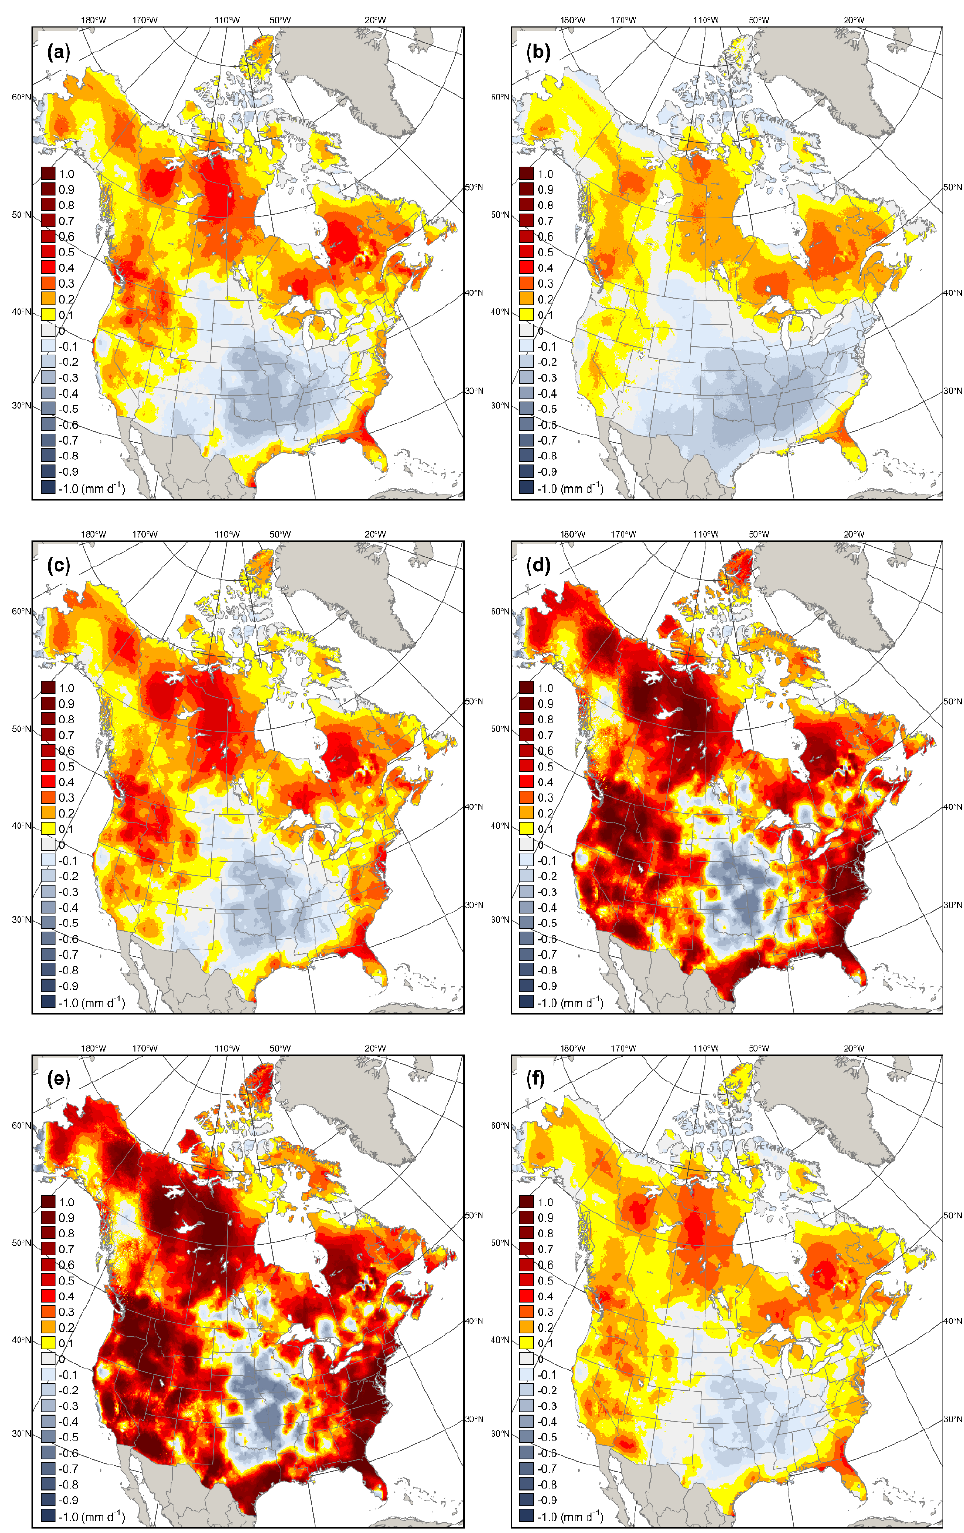
Figure 8. Long-term change in warm-season (May–September) mean potential evaporation (PE) from 1951–2014 (mm · day − 1 ): ( a ) Penman’s model ( E Pen ); ( b ) Priestley–Taylor model ( E PT ); ( c ) reference grassland ( E RG ); ( d ) reference forest with moderately coupled canopy ( E RFu ); ( e ) reference forest with well coupled canopy ( E RFc ); ( f ) linear mixed-effects model fit to monthly mean pan evaporation ( E PanFit ). Values were calculated by multiplying the slope coefficient from regression relationship between PE and time by the length of the study period (64